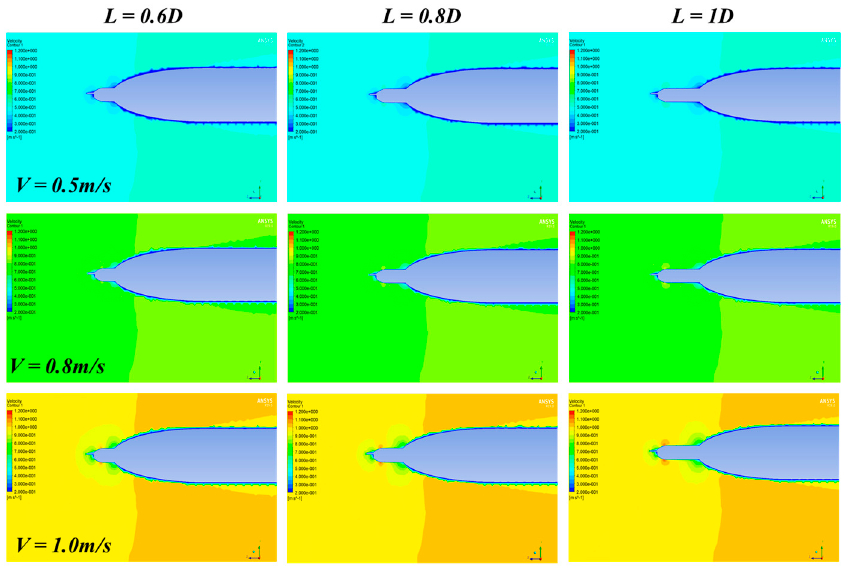
Figure 4. Velocity vectors of the turbulence AUV under various models with 0° AOA. The rows represent the same velocity of the flow field and the columns represent the same distance X.